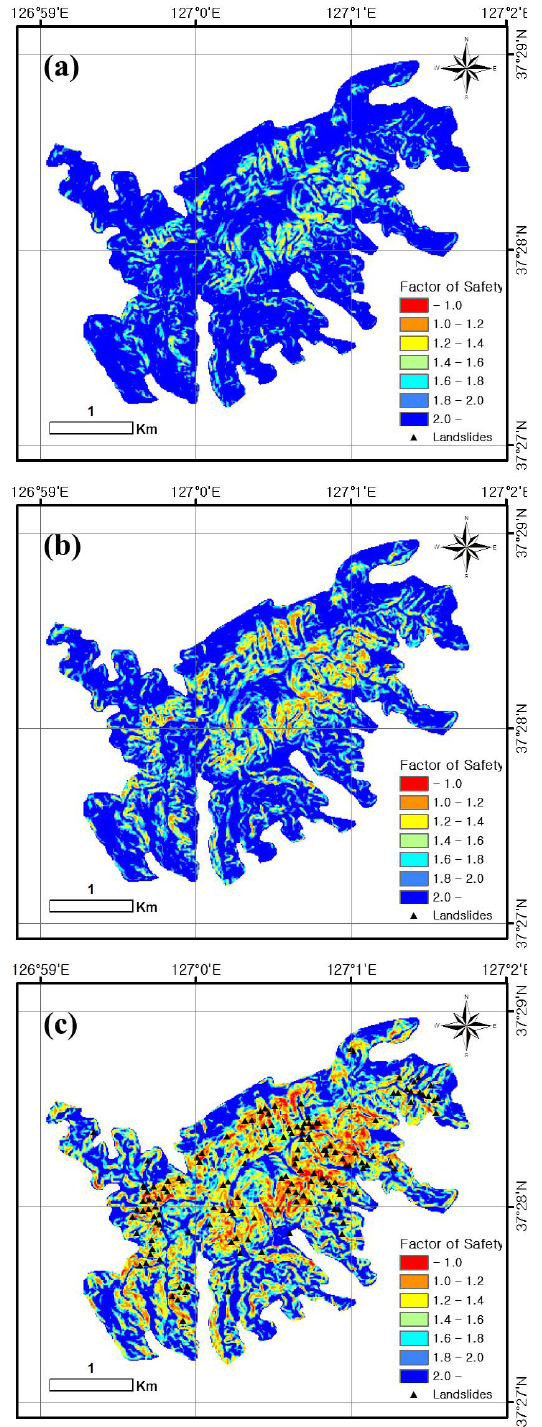
Fig. 12. Classes of topographic parameters (elevation, slope angle, aspect and curvature) for (a) 0h (09:00, 25 July 2011), (b) 46h (07:00, 27 July 2011), and (c) 48h (09:00, 27 July 2011).